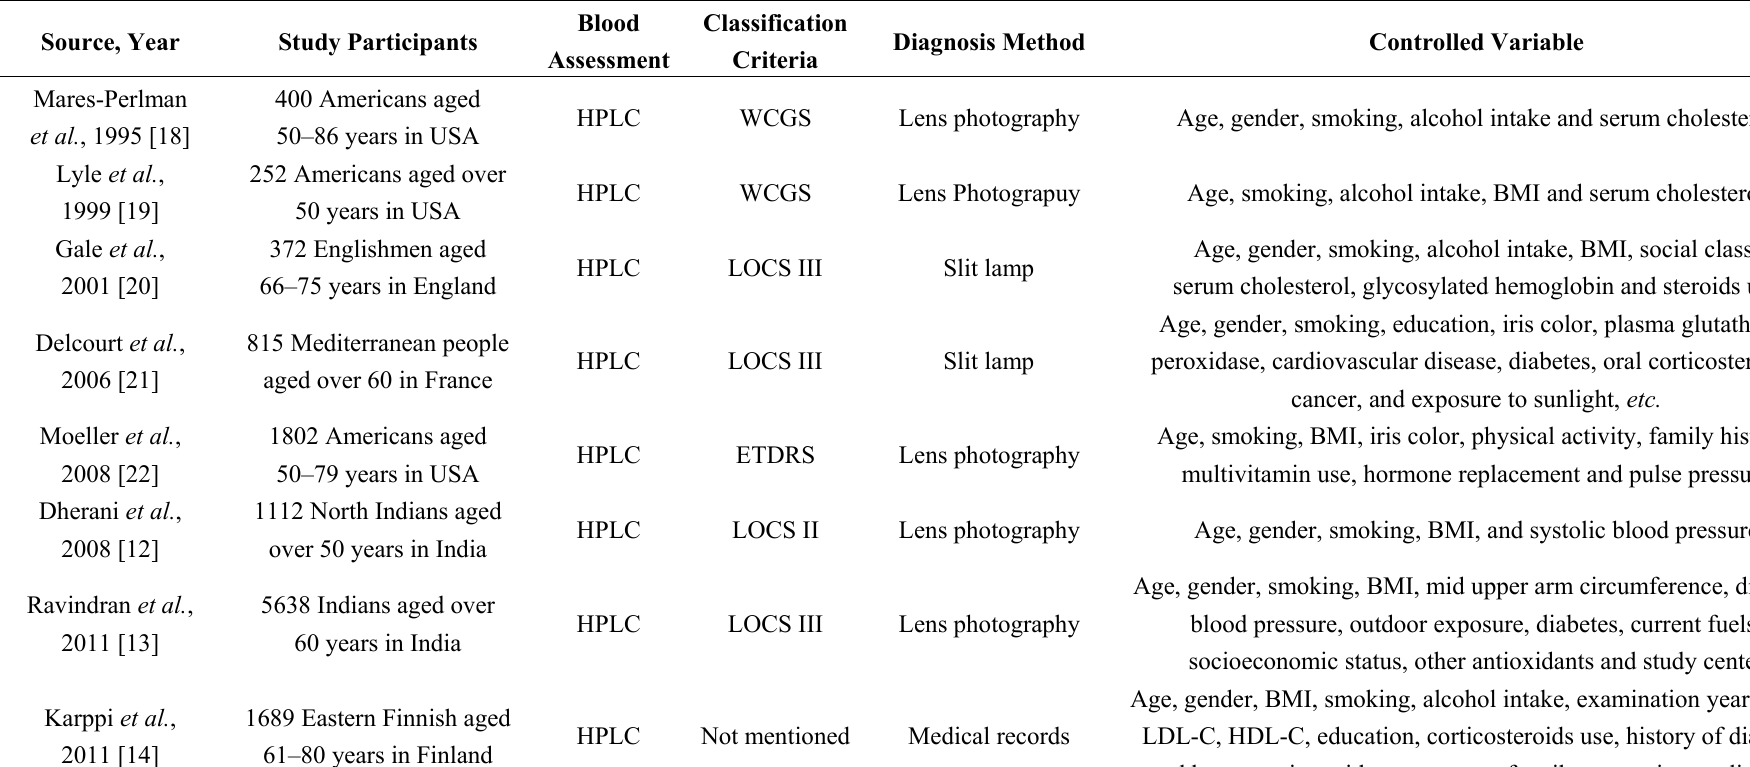
Table 1. Characteristics of studies of blood lutein and zeaxanthin and risk of age-related